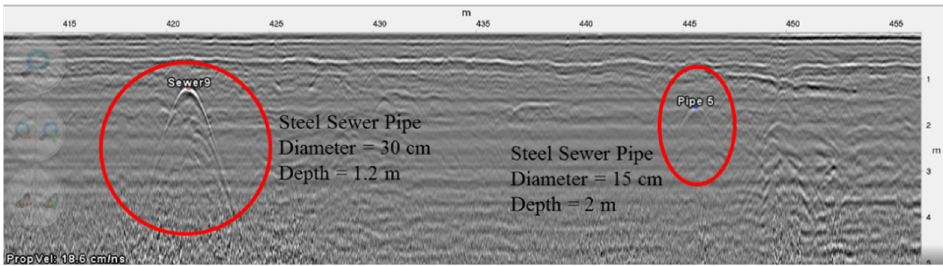
Figure 12. GPR electromagnetic scan with interpretation after data processing.